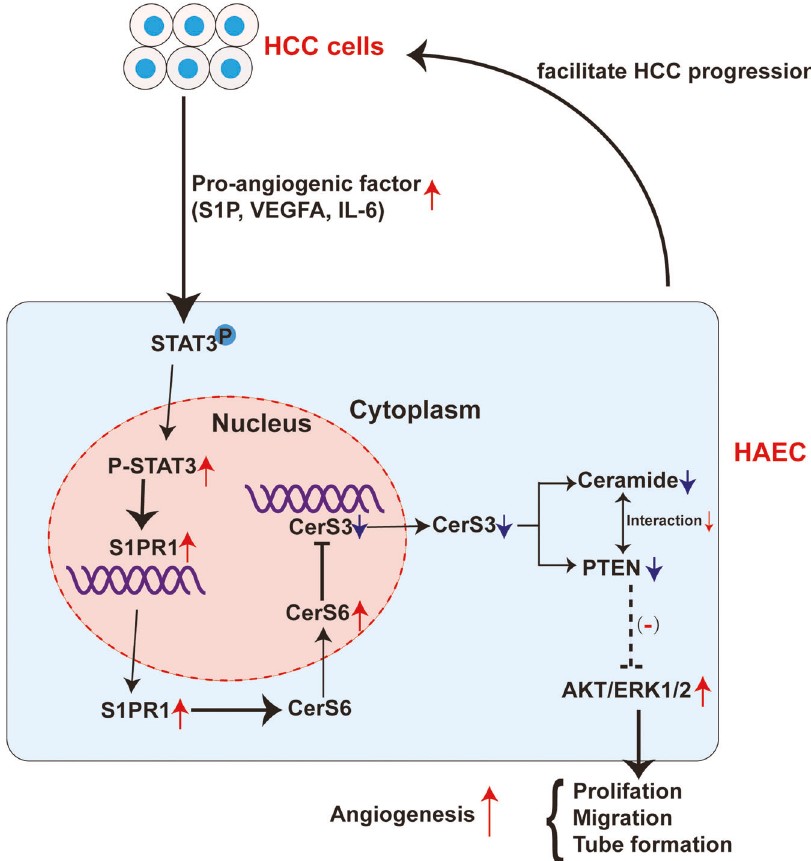
Fig. 9 Schematic depiction of the underlying mechanisms of upregulation of S1PR1 in HAECs to promote angiogenesis in HCC. The conditioned medium from HCC cells, containing S1P, IL-6 and VEGFA, induced the overexpression of S1PR1 via the activation of STAT3; overexpression of S1PR1 controls CerS6 translocation into the nucleus of ECs and then inhibits CerS3 expression at the transcriptional level, lead to a decrease in ceramide and PTEN levels, then reduces the interaction between ceramide and PTEN and activates AKT/ERK signalling to promote angiogenesis. Besides, the promotion of angiogenesis in HAECs facilitates HCC